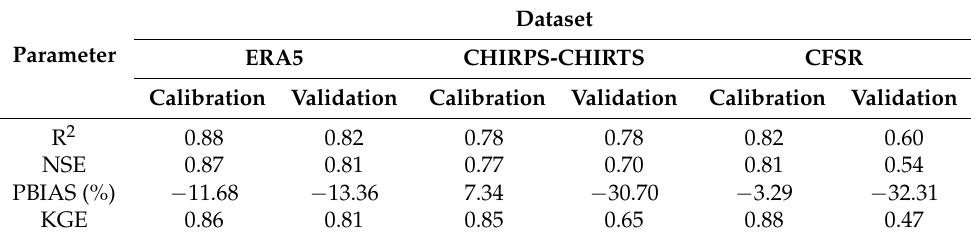
Table 5. SWAT model performance compared with GloFAS discharge data.